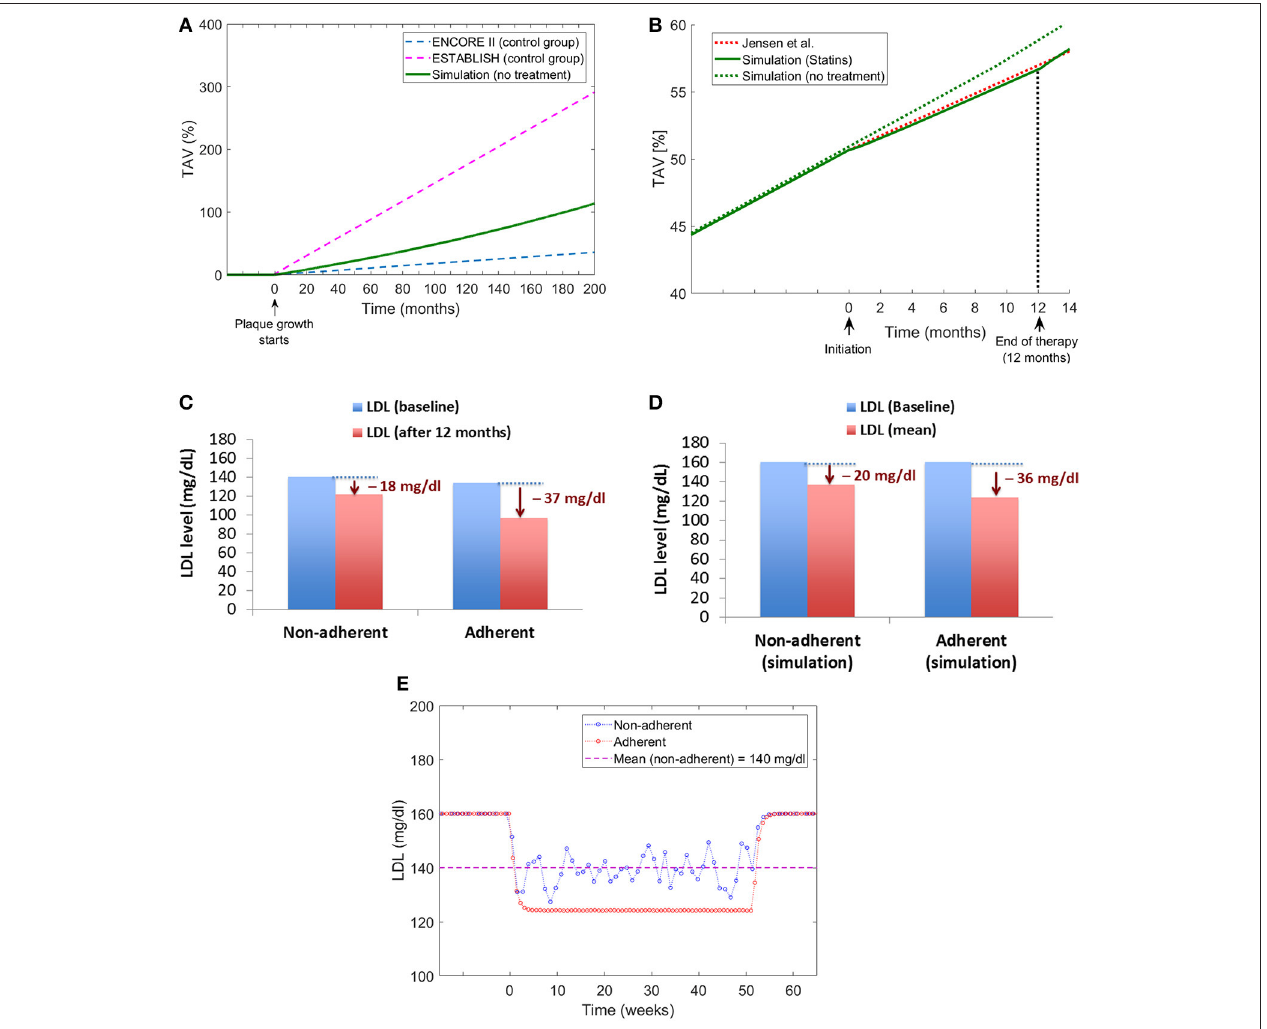
FIGURE 11 | Model validation. (A) Comparison of plaque growth simulated by the QSP model with trends reported by clinical trials [ENCORE II (Lüscher et al., 2009) and ESTABLISH (Okazaki et al., 2004)]. (B) Comparison of the plaque growth simulated by the model with the change in plaque growth trend reported by Jensen et al. (2004). (C) Changes in LDL levels for adherent and non-adherent patients after 12-month statin treatment reported by Kazerooni et al. (2013). (D) Changes in LDL levels obtained from the QSP model for adherent and non-adherent patients. (E ) Time course of LDL changes due to treatment for adherent and non-adherent patients obtained from the QSP model